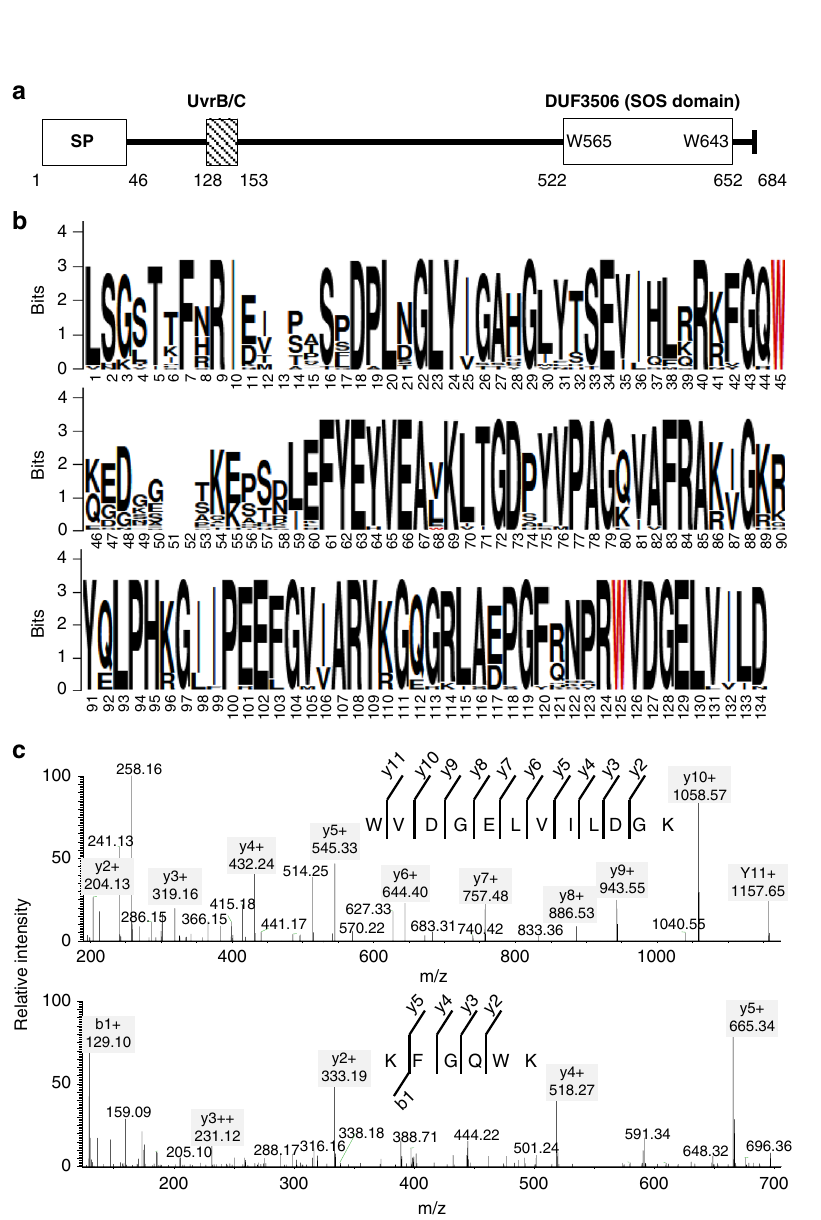
Fig. 3 Trp643 is located in the DUF3506 domain. a EX1 protein comprises two predicted domains, UvrB/C and DUF3506. b Multiple alignment reveals that the DUF3506 domain is highly conserved across different plant species. The sequences of the EX1-like protein from the 27 plant species reported in Phytozome v12.1 were aligned using ClustalW. Two Trp residues, Trp565 and Trp643, were highlighted in red. Aligned DUF3506 domain sequences were visualized using WEBLOGO. c Tandem MS spectra of peptides 562 GQWKGGK 569 and 643 W ox VDGELVILDGK 654 revealed the speci fi city of Trp643 in the context of Oxi-PTM. This experiment was repeated using three independent biological samples with reproducible results NATURE COMMUNICATIONS| (2019) 10:2834